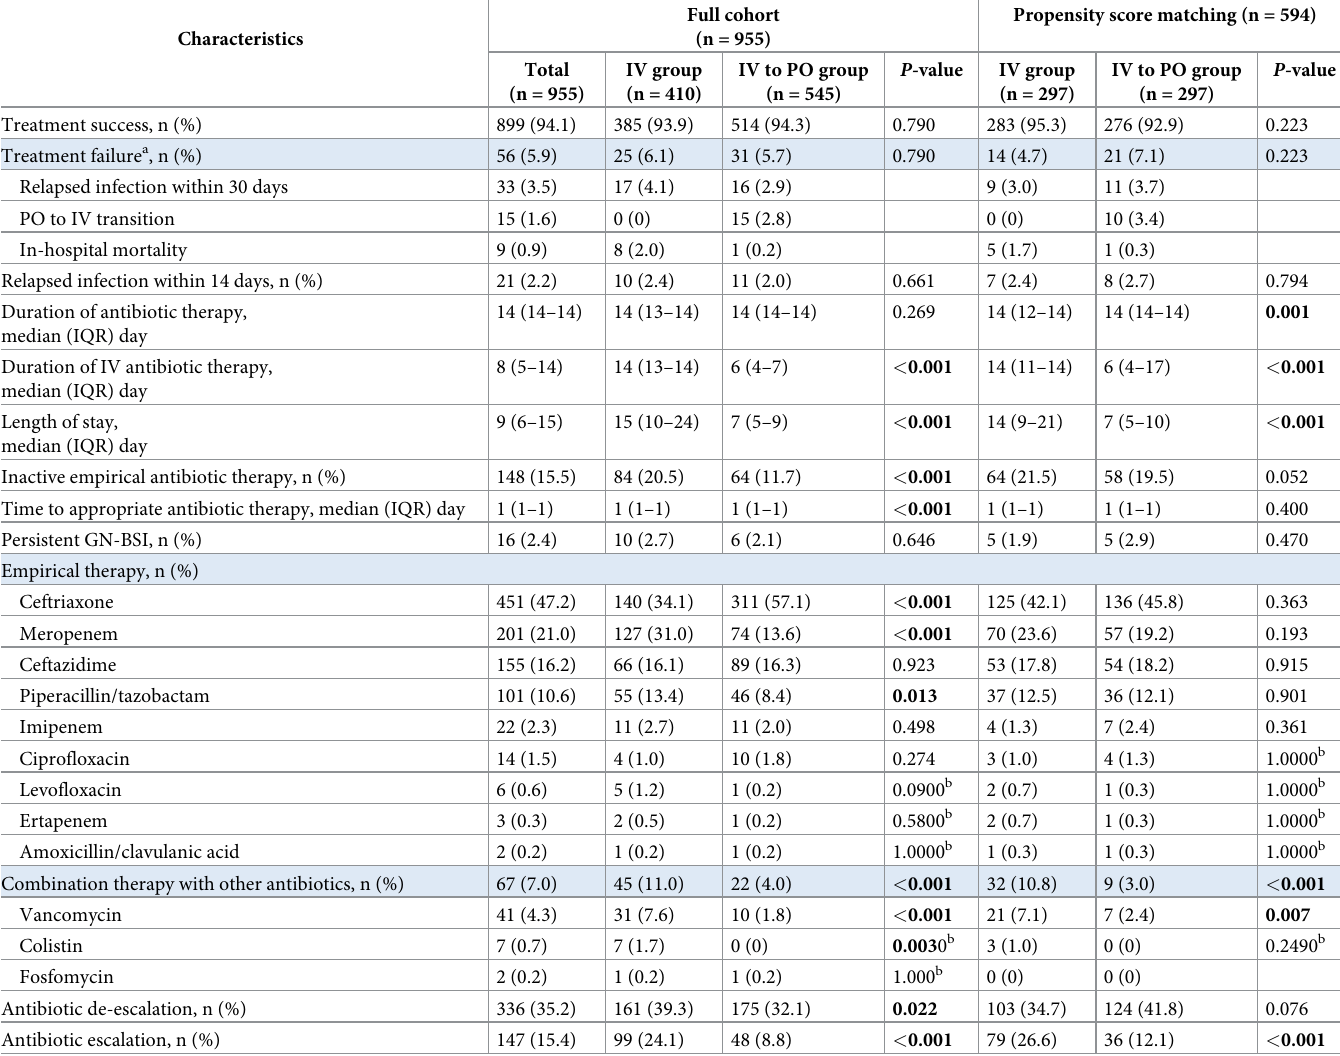
Table 3. Treatment and outcomes of hospitalized patients with Gram-negative bloodstream infection treated with intravenous antibiotic agents or receiving intra- venous to oral transition antibiotics (n = 955), and after propensity score matched cohort (594).